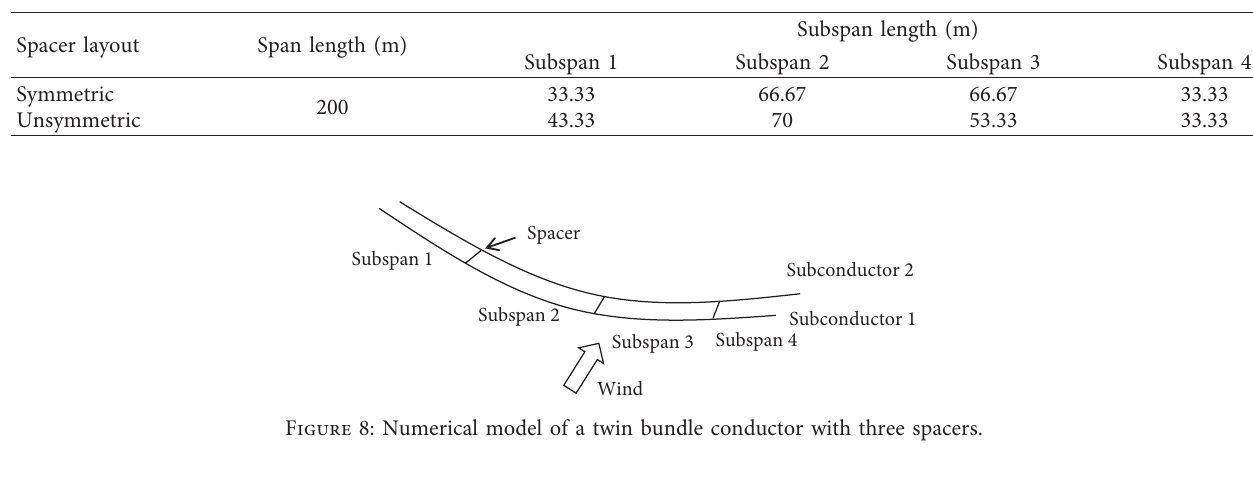
Table 2: Subspan length of the 200 m span line with different spacer layouts.